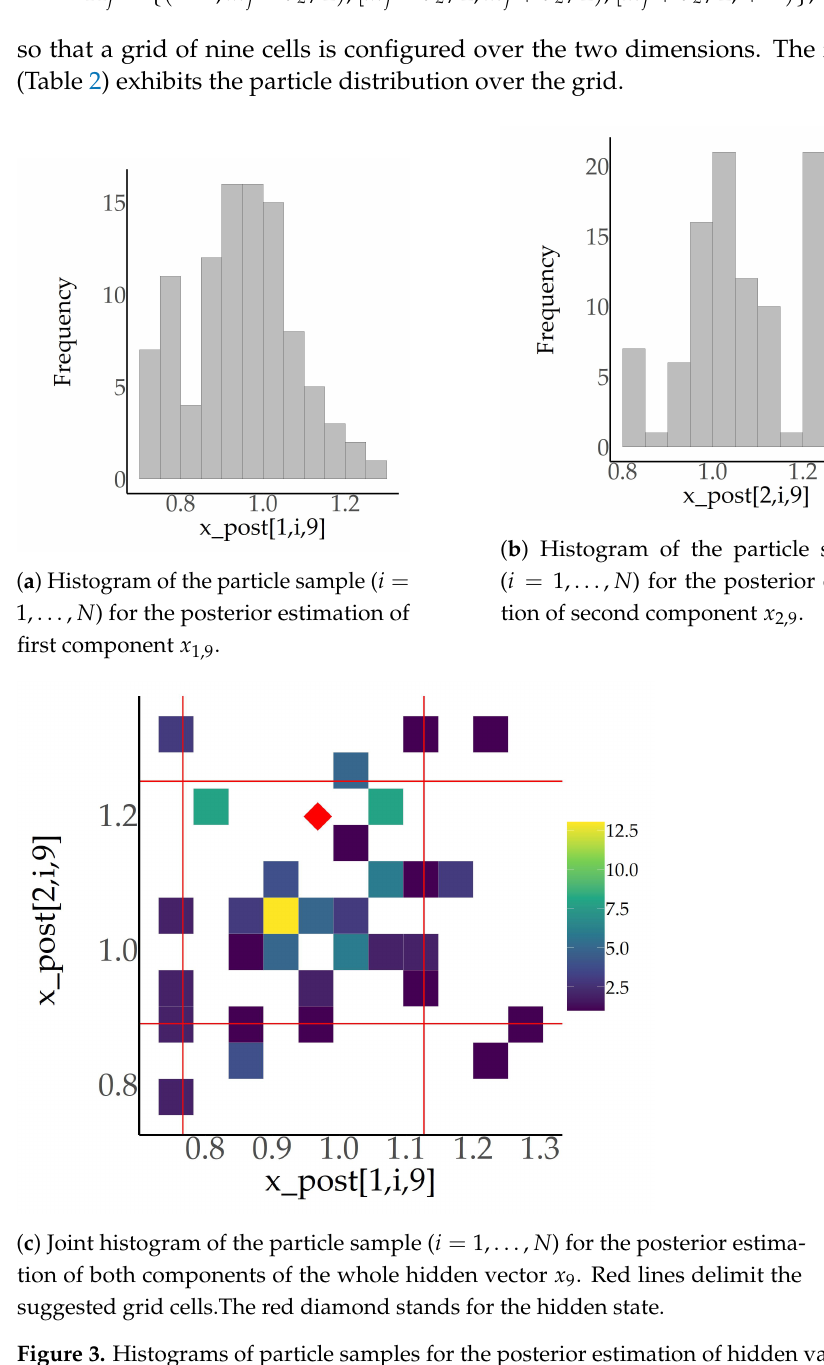
Figure 3. Histograms of particle samples for the posterior estimation of hidden variable x 9